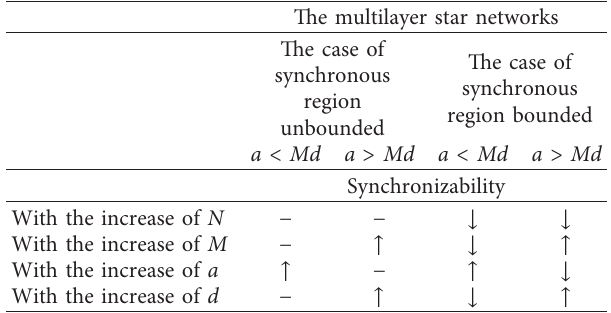
Table 1: When d 0 ≠ d , the synchronizability of the multilayer star networks varies with N , a , d , d 0 , and M .